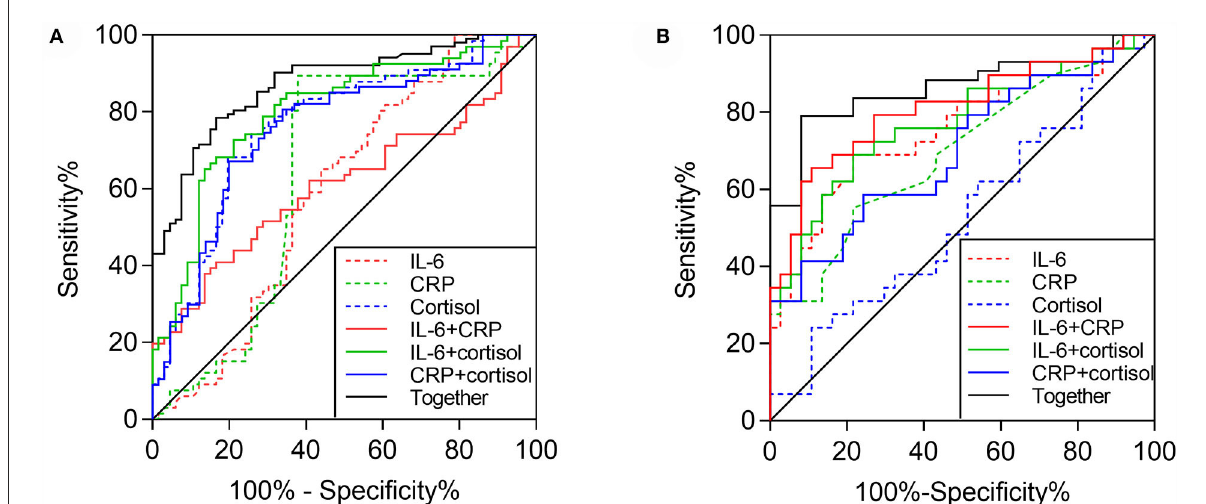
FIGURE3 Area under the curves (AUCs) reflect the discriminating potential of different combinations of IL-6, CRP, and cortisol. (A) AUCs between MDD and HC (together: AUC = 0.873, P < 0.001; IL-6 + CRP: AUC = 0.611, P = 0.028; IL-6 + cortisol: AUC = 0.801, P < 0.001; CRP + cortisol: AUC = 0.756, P < 0.001; cortisol: AUC = 0.765, P < 0.001; CRP: AUC = 0.640, P = 0.006; and IL-6: AUC = 0.592, P = 0.069); (B) AUCs between anhedonic and nonanhedonic MDD (together: AUC = 0.864, P < 0.001; IL-6 + CRP: AUC = 0.811, P < 0.001; IL-6 + cortisol: AUC = 0.722, P < 0.001;